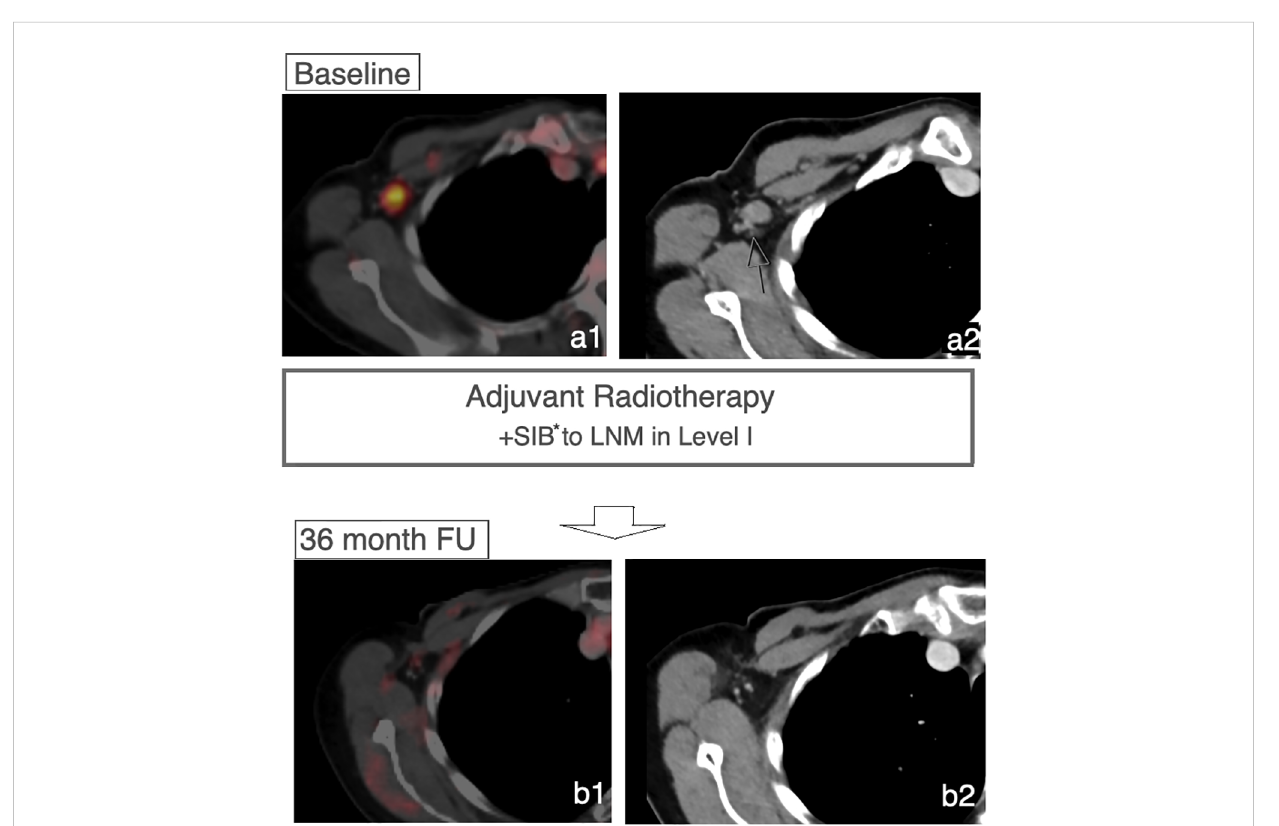
FIGURE 3 Controlled LN after LN-SIB. Case of a patient receiving a LN-SIB to a remaining sLN in Level I. FDG-PET/CT imaging after 36 months shows regression without signs of recurrence within the lymphatic drainage system. *Dose 58.8 Gy in 28 Fx.